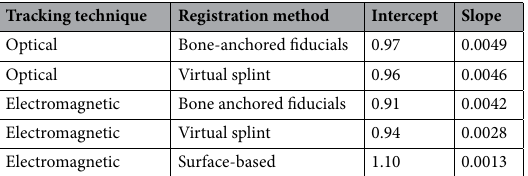
Table 4. Intercept and slope value estimates for each combination of tracking technique and registration method.